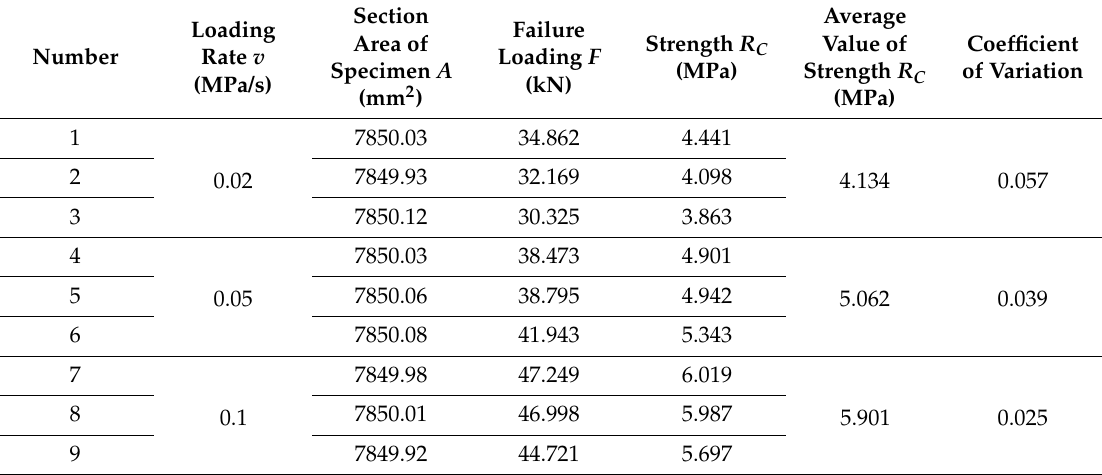
Table 7. Test results of unconfined compressive strength of asphalt